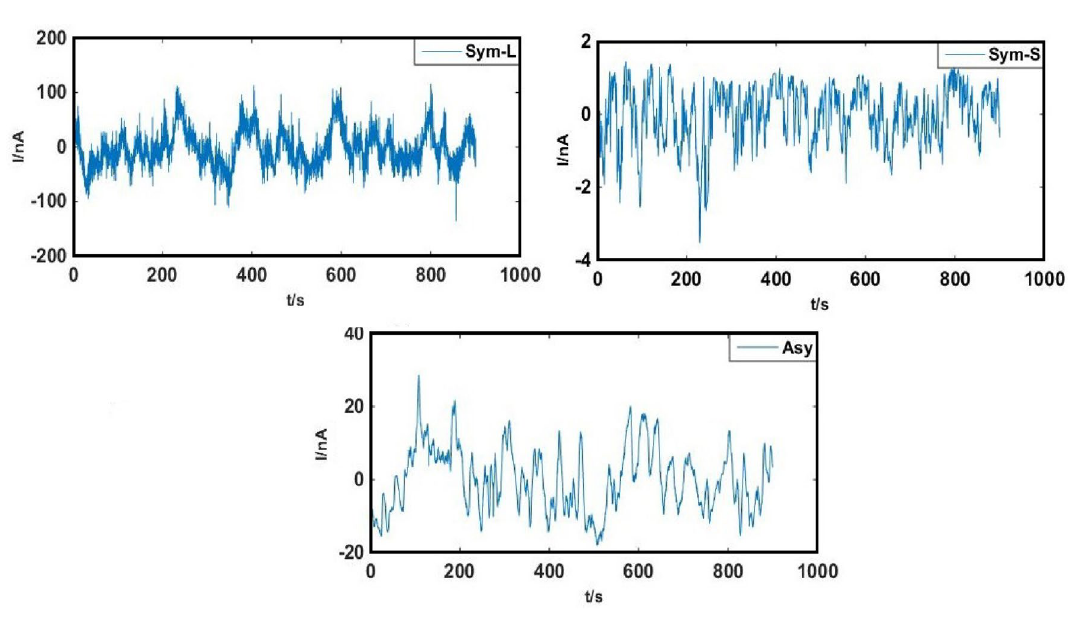
Figure 5. The ECN signals depicted in Fig. 4. After trend